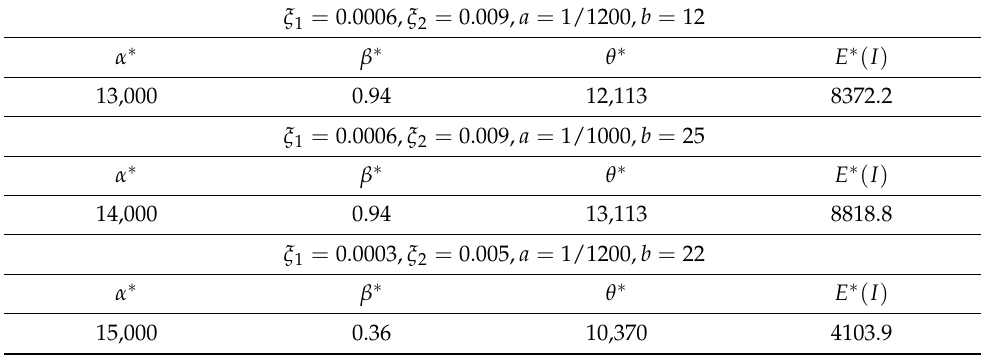
Table 1. Optimal solutions with different values of